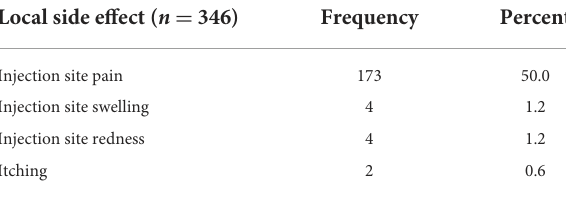
TABLE 8 Local side effects of COVID-19 vaccine among healthcare workers in Ethiopia, 2021.